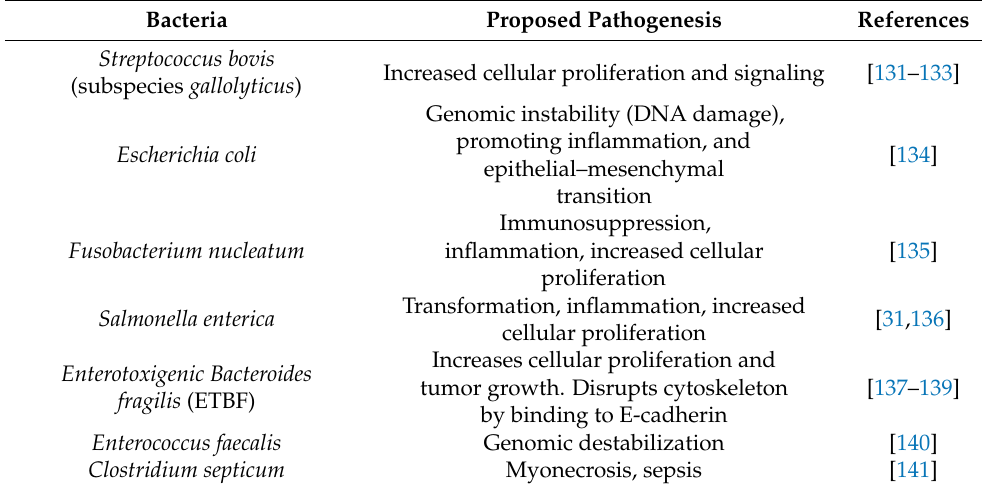
Table 2. Overview of bacteria associated with colorectal